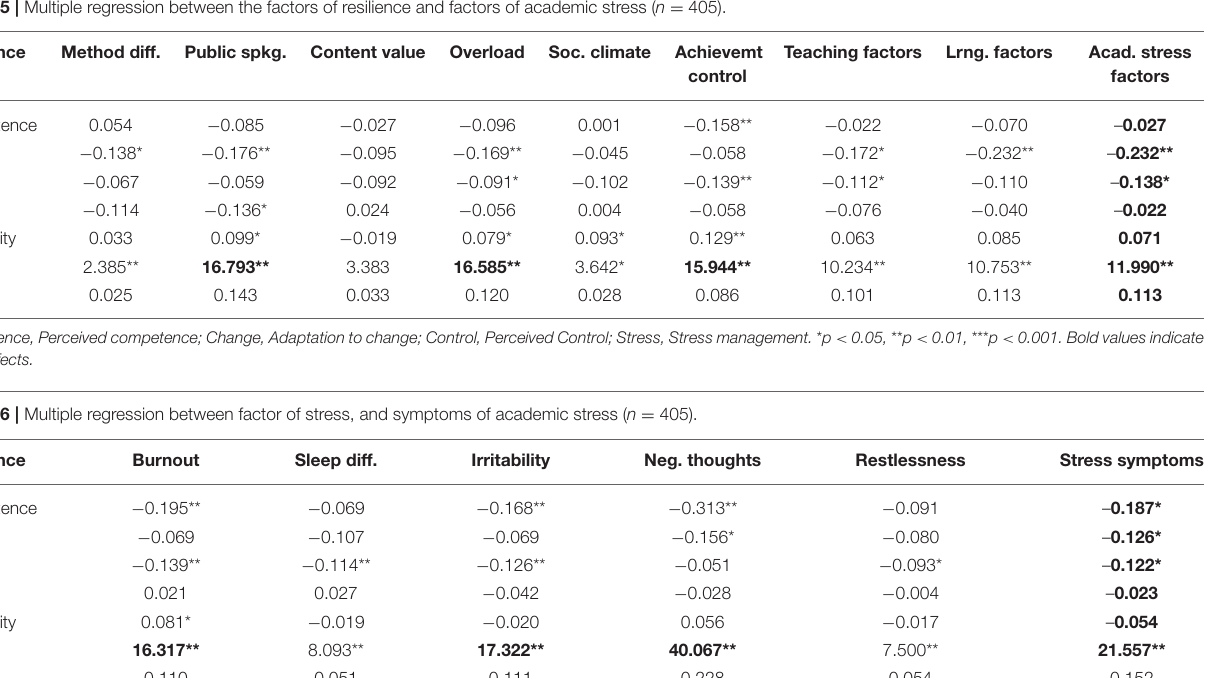
TABLE 5 | Multiple regression between the factors of resilience and factors of academic stress ( n = 405). Resilience